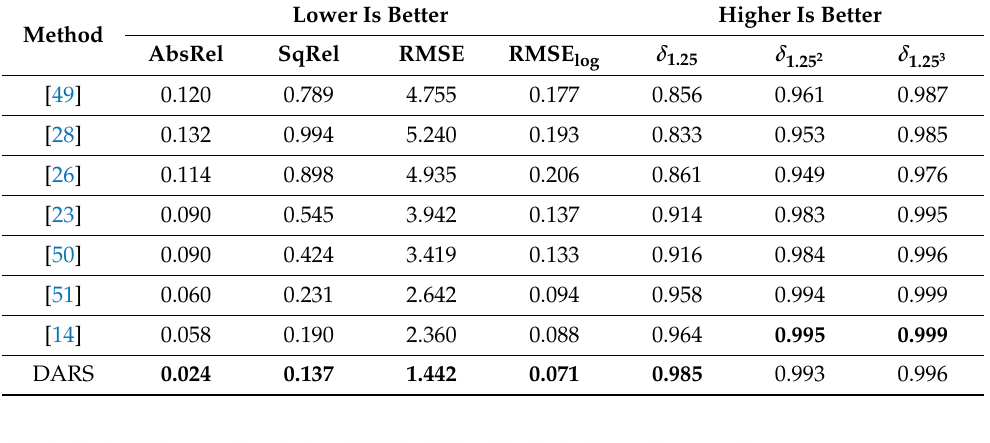
Table 2. Comparative study on KITTI. The first part from above contains unsupervised methods while the second part is dedicated to supervised ones.